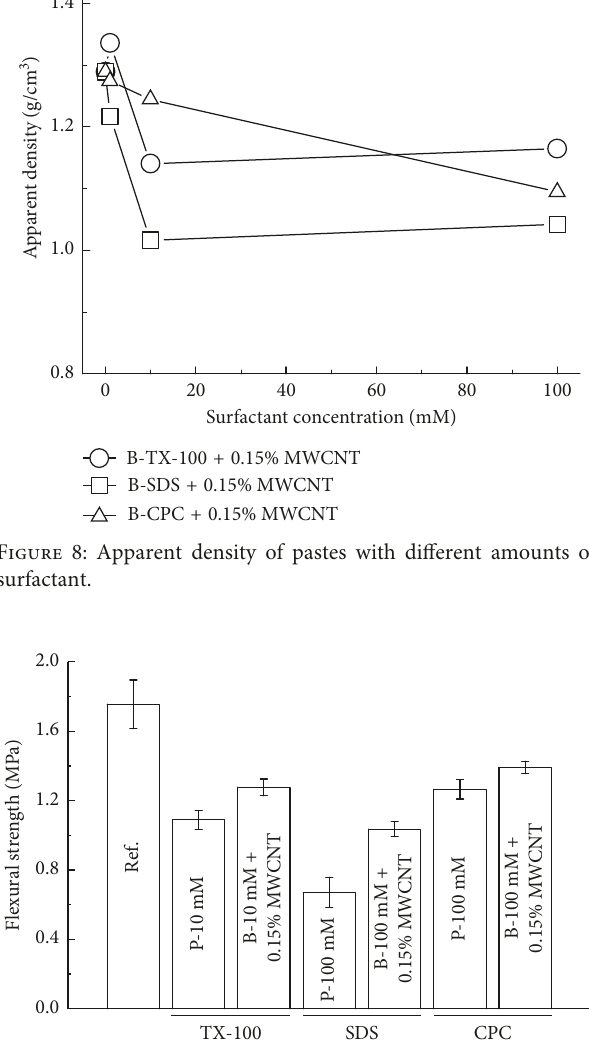
Figure 11: Apparent density versus flexural strength correla- tions for all pastes tested in three-point bending (P: plain paste; B: blended